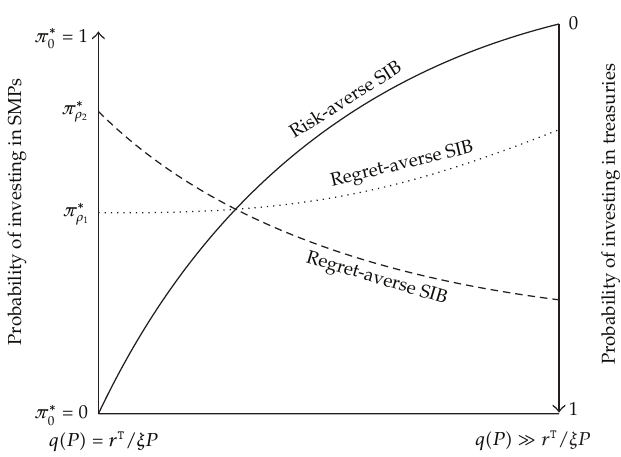
Figure 5: Investor’s optimal risk and